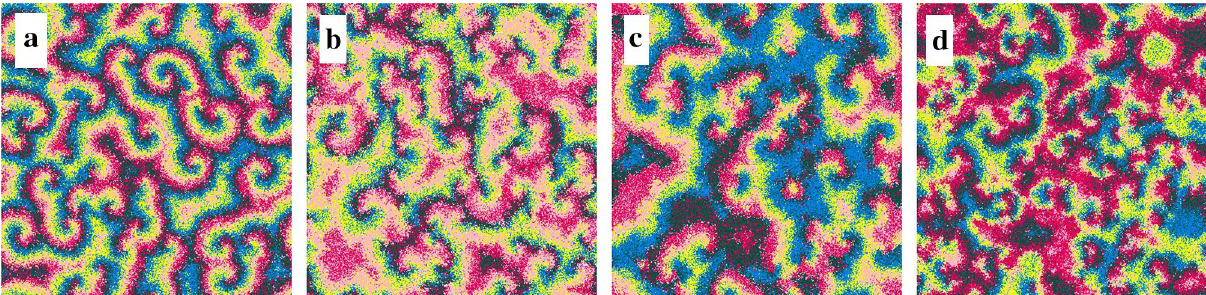
Figure 2. Snapshots of simulations of the generalisation of the rock-paper-scissors game illustrated in Fig. 1 running in square lattices with 500 2 grid points. Each dot shows either an individual (according to the colour scheme in Fig. 1) or an empty site (white dot). All simulations started from the same random initial conditions. The snapshots show the spatial patterns for the standard model ( a ), Attack ( b ), Anticipation ( c ), and Safeguard tactics ( d ), respectively, at t = 5000 generations. See also the videos for the whole simulation for the Standard case (https:// youtu. be/ Ndvk6 Rg57m4), Attack (https:// youtu. be/ JGhkD AHSo74), Anticipation (https:// youtu. be/ ZZp9Q lOfv2Q), and Safeguard (https:// youtu. be/ eFxWd LhIOuQ). The results were obtained for R = 3 and s = r = m = 1 / 3